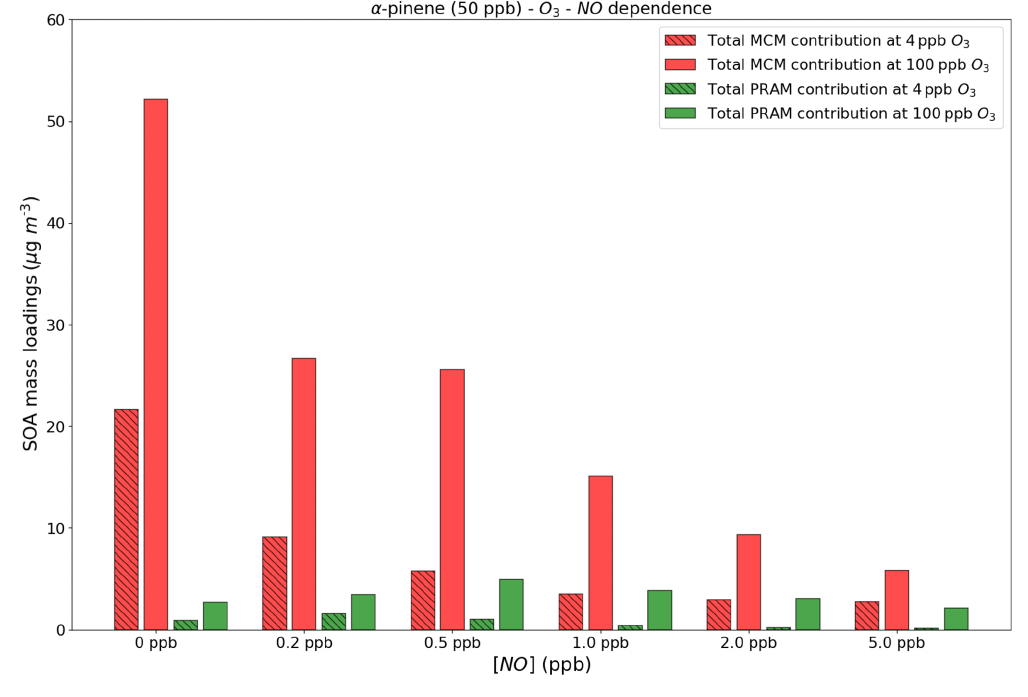
Figure 7. Contribution to the SOA mass loadings by total PRAM and MCM compounds at different NO levels and O 3 concentrations. For comparison we use 4 and 100ppb O 3 concentrations, respectively, at 50ppb α